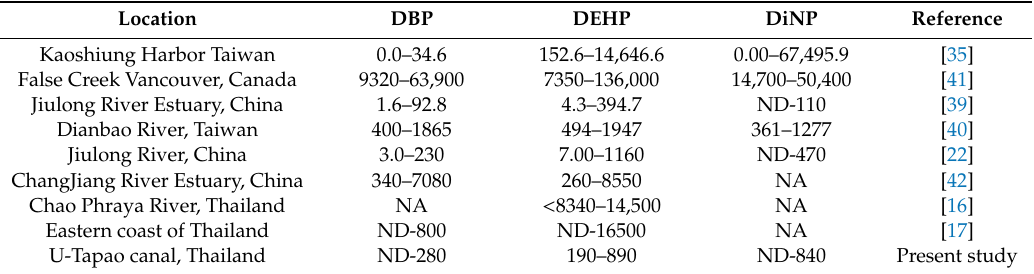
Table 4. Comparison of di-n-butyl phthalate (DBP), di-2-ethyl hexyl phthalate (DEHP) and di-isononyl phthalate (DiNP) levels in di ff erent countries (ng / g dw).